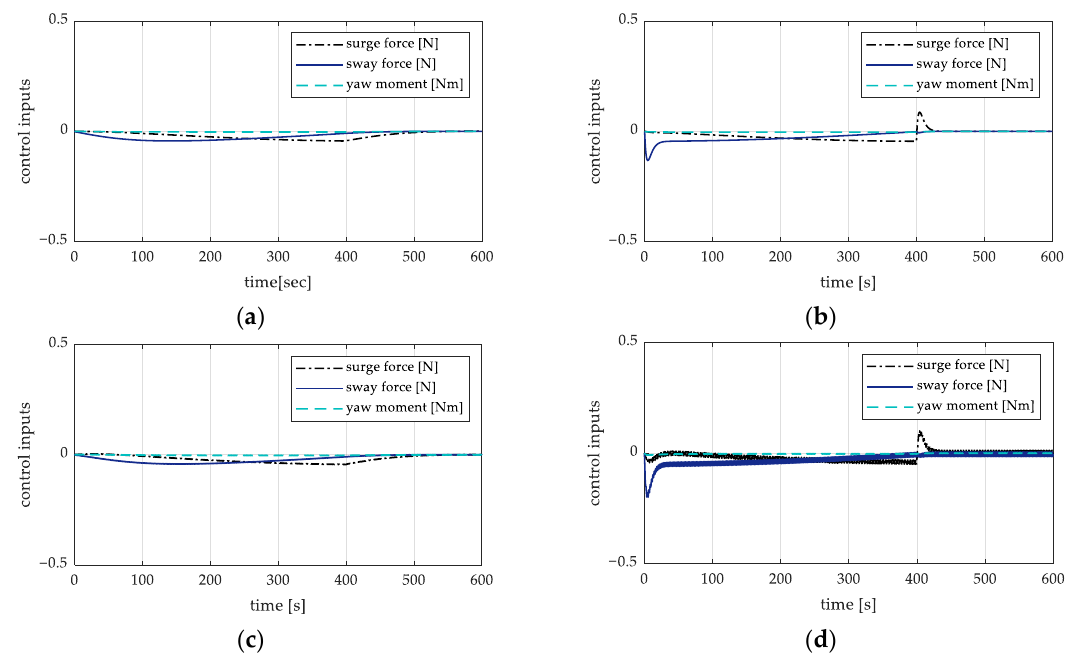
Figure 10. The control inputs of the barge ship. ( a ) Conveyed with the H ∞ controller; ( b ) con- veyed with our sliding mode controller; ( c ) conveyed with the H ∞ controller under disturbance; ( d ) conveyed with our sliding mode controller under disturbance.